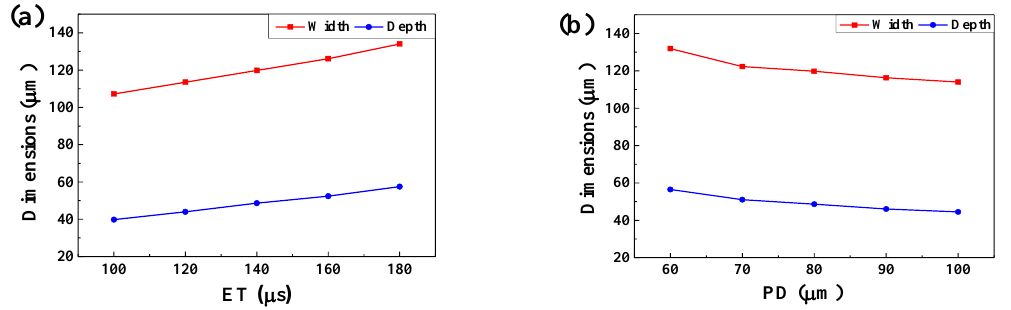
Figure 8. The width and depth of melt pool with different ET (PD = 80 μs) ( a ) and different PD (ET = 140 μs) ( b ).